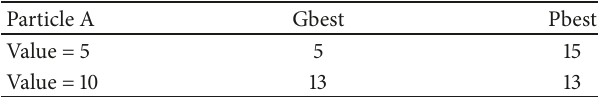
Table 1: The value and position of Particle